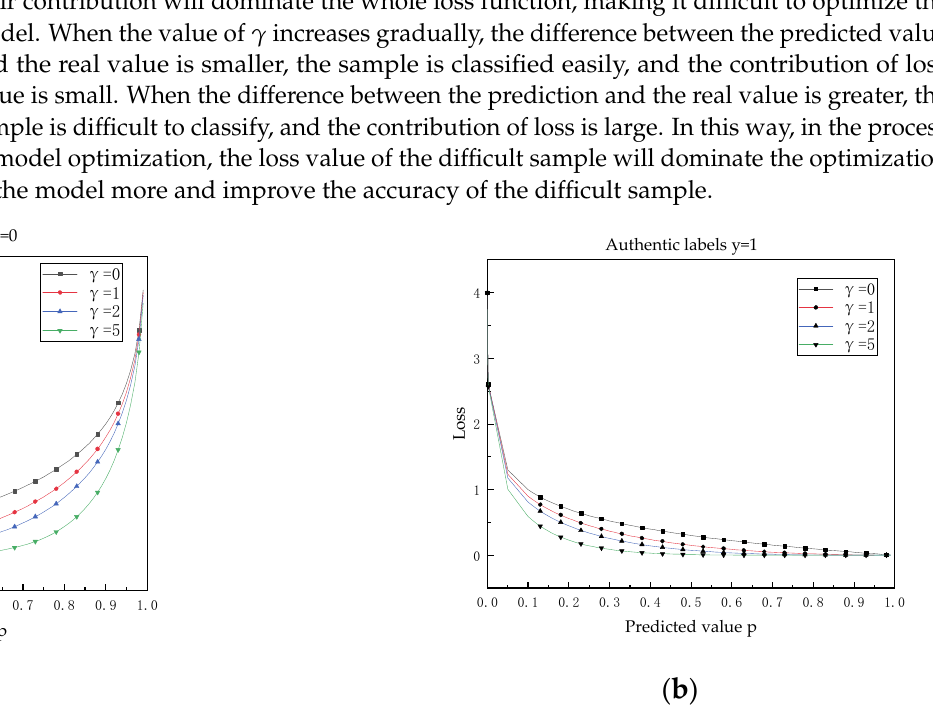
Figure 2. Focal loss decay curve. ( a ) Authentic labels y = 0. ( b ) Authentic labels y = 1.